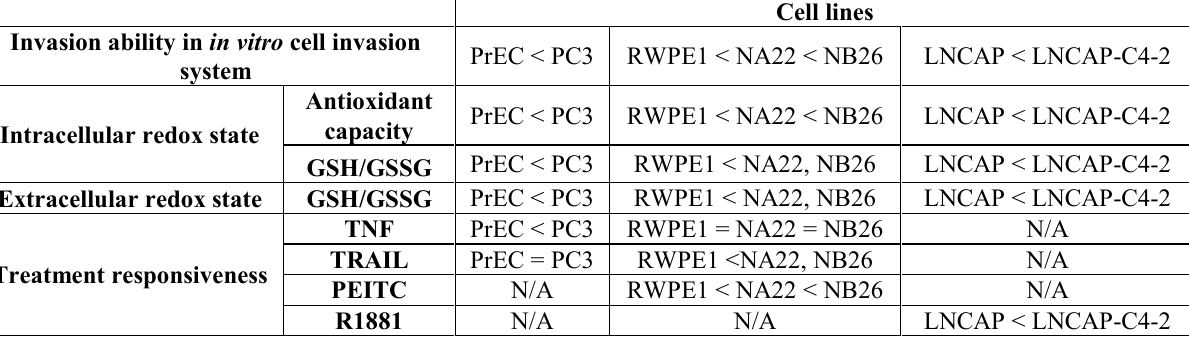
Table 1. Summary of redox states and responsive to therapeutic agents of PrEC,